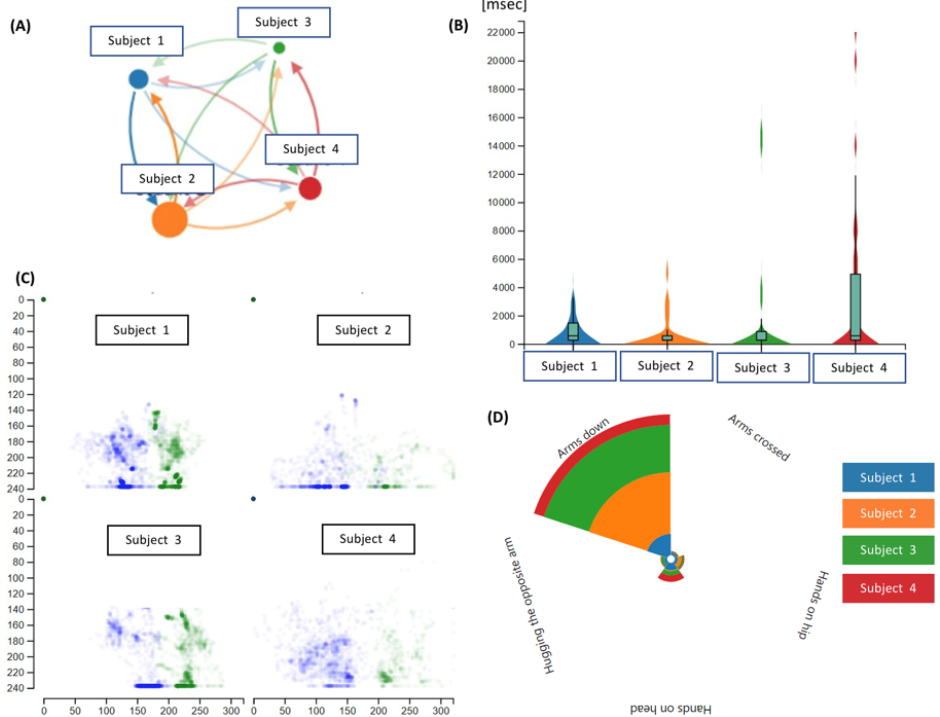
Figure 5. Visualizations for the Collaborative Activity. ( A ) Spoken interaction graph. ( B ) Violin Plot of Spoken Interactions. ( C ) Heat Map of Hand Positions. ( D ) Posture Proportion